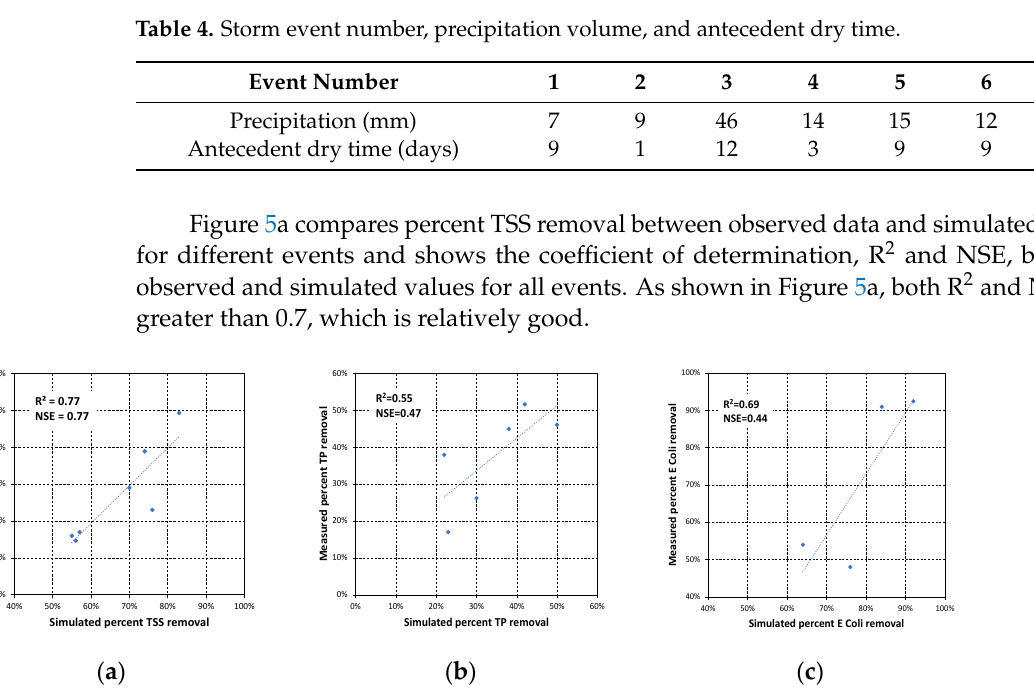
Figure 5. Scatter diagram of observed and simulated values for ( a ) percent TSS removal, ( b ) percent TP removal, and ( c ) percent E. coli removal.